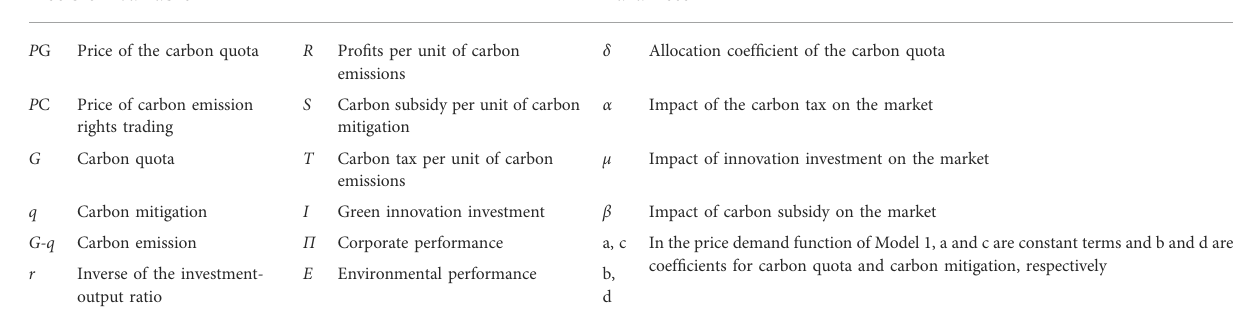
TABLE 1 De fi nition of decision variables and